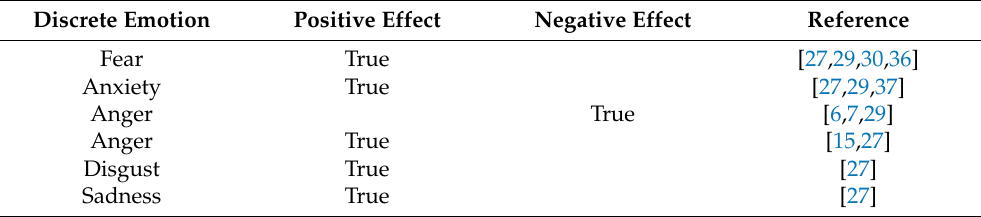
Table 1. The relationships between discrete emotions and risk perception. Discrete